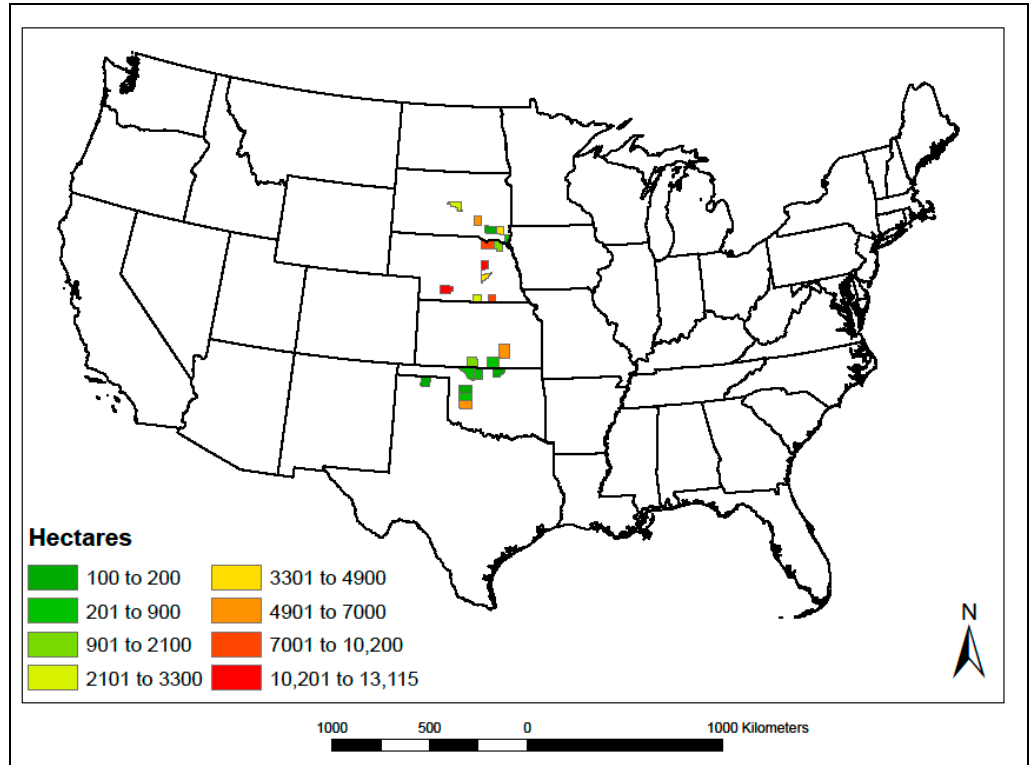
Figure 9. Counties with Increasing Cropland and Declining Rangeland or Forest. Map by author.